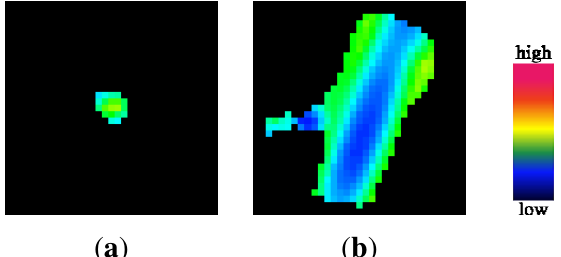
Figure 6. Results obtained by applying the moment-of-inertia filter. ( a ) nodule; ( b ) blood vessel.